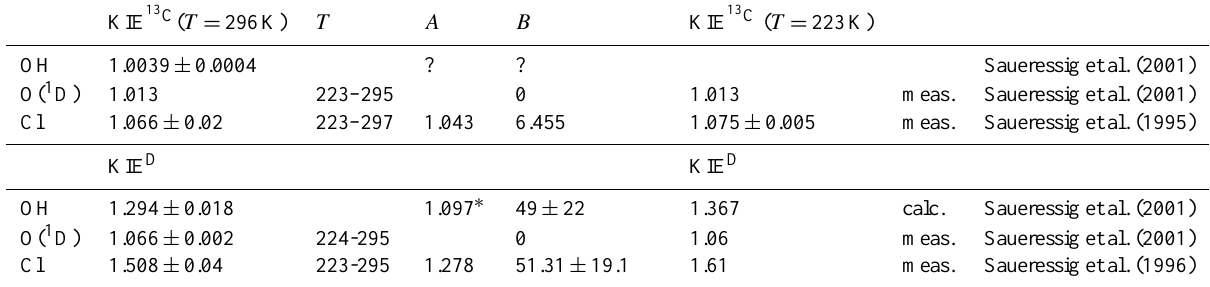
Table 1. Measured and calculated kinetic isotope effects and coefficients for their temperature dependence KIE (T ) = A exp (B/T )